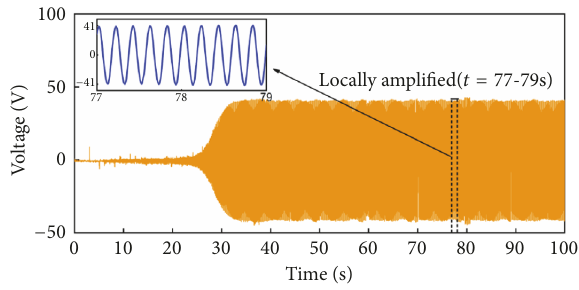
Figure 6: Time history curve of voltage